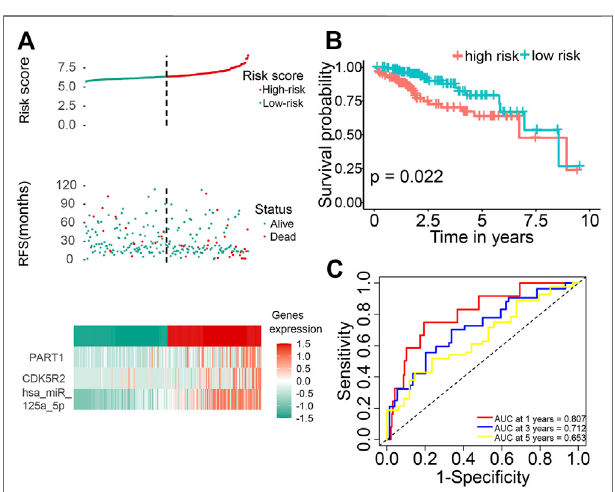
FIGURE 6 | Identi fi cation of a three-ceRNA signature was signi fi cantly associated with OS of patients with HCC. (A) Risk score distribution, survival status,andthree-ceRNAexpressionpatternsofpatientswithHCCinthehigh- risk and low-risk groups. (B) The K – M curve of OS of the three-ceRNA signature. (C) Time-dependent ROC curves analysis at 1, 3, and 5